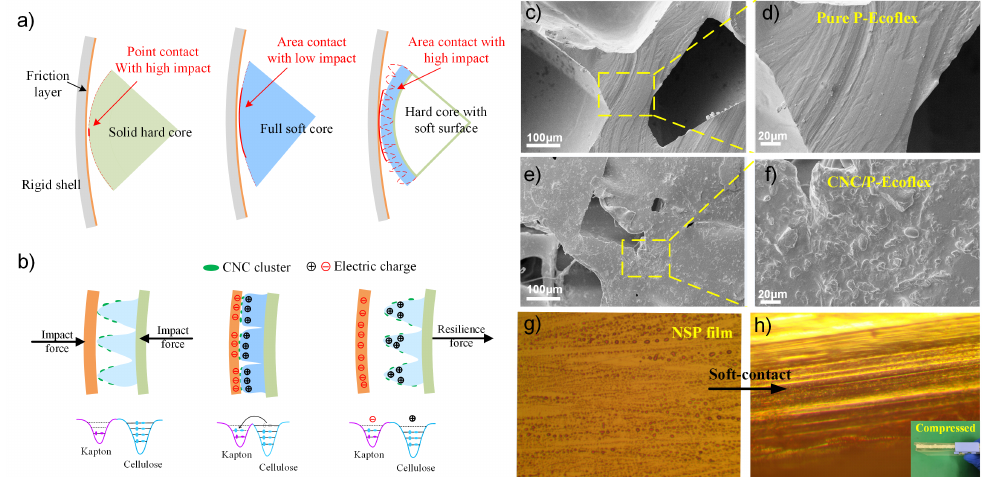
Figure 5. ( a ) Partial enlargement schematic diagram and comparison of the contact modes for other typical rolling spherical TENGs; ( b ) the triboelectrification of the cellulose-fiber-enhanced core before and in contact with the Kapton friction layer based on soft contacting; ( c – f ) SEM images of the surface of CNC/P-Ecoflex; ( g , h ) Optical micrographs of the NSP film soft-contact process. (The magnification is